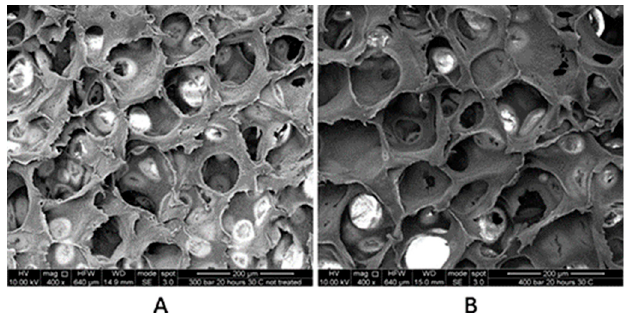
Figure 3. SEM images of cross sections of not treated ( A ) and CO 2 treated ( B ) PLLA scaffolds (40 MPa, 20 h and 40 ° C). Reprinted from S. Lanzalaco, S. Campora, V. Brucato, et al., J. Supercrit. Fluids. 2016, 111, 83–90 [54]. Copyright 2016, with permission from Elsevier.